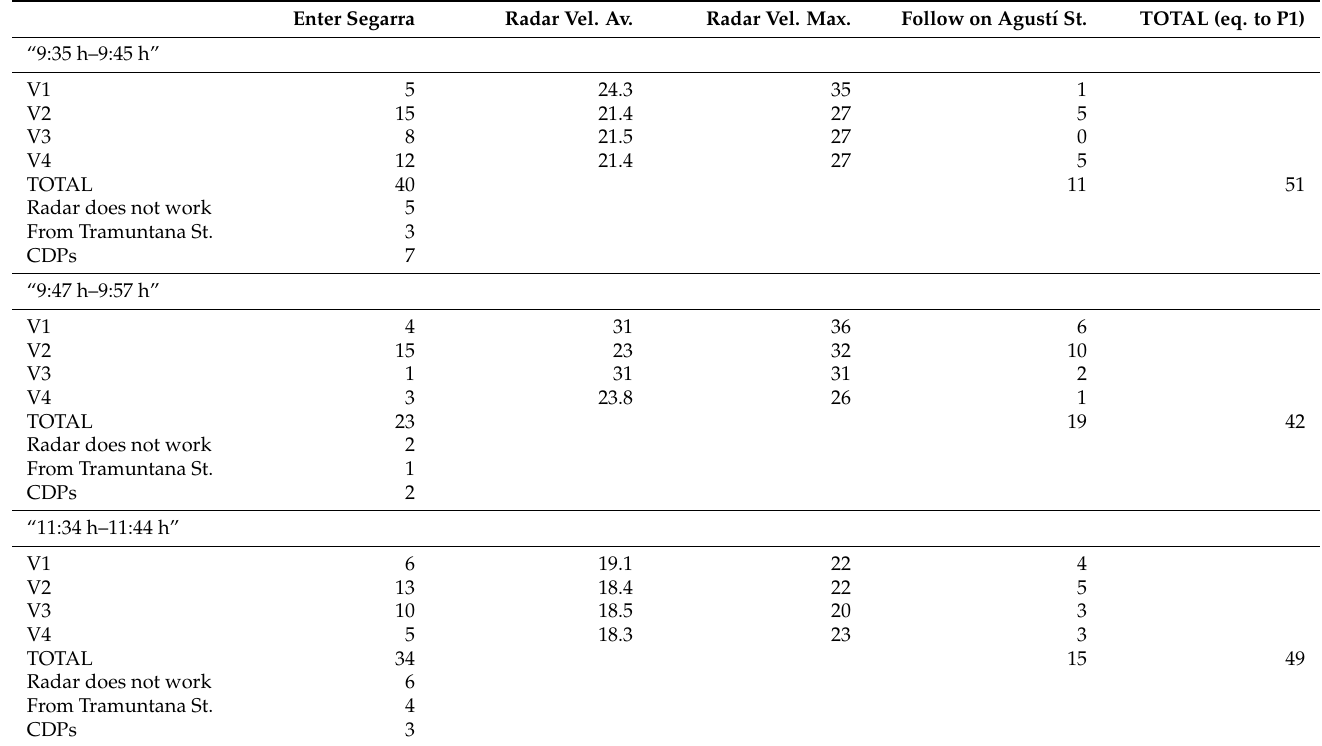
Table 6. Qualitative sample for Segarra